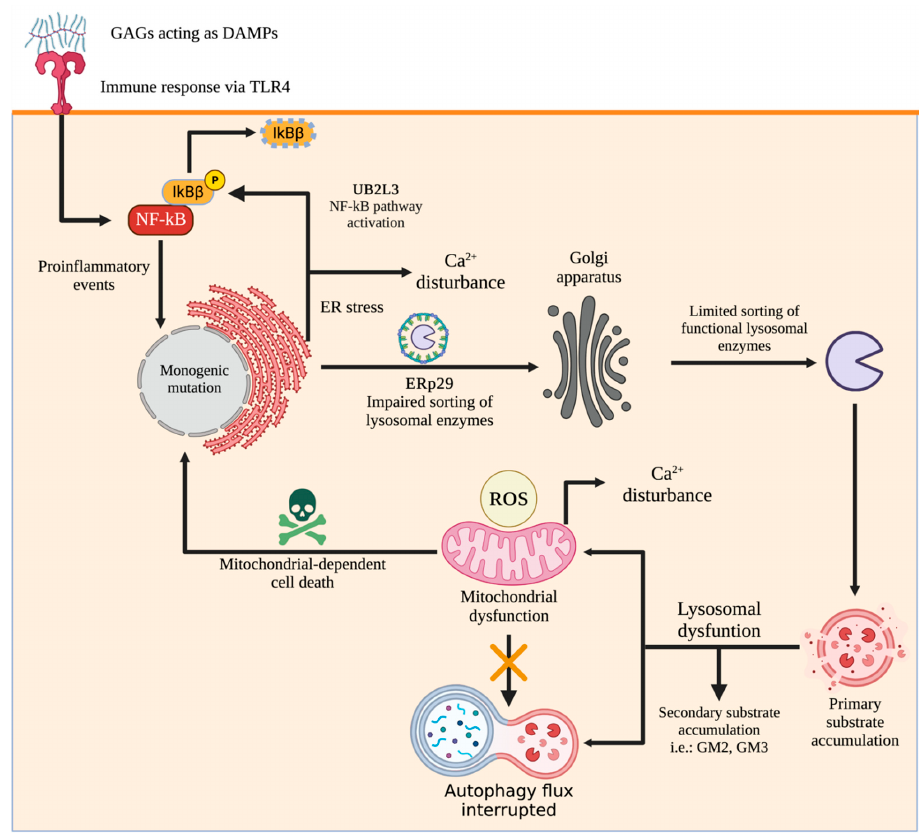
Figure 1. Global cellular changes occur during GAG accumulation. Note that primary GAG accu ‐ mulation affects not only lysosomal function but also any intracellular organelles contributing to altered cell homeostasis. Since GAGs act in cell–cell communication, their extracellular accumula ‐ tion, due to lack of plasma turnover [77], promotes inflammation ‐ related activation pathways since they are recognized as damage ‐ associated molecular patterns (DAMPs). For instance, soluble HS fragments can act as Toll ‐ like receptor 4 antagonists supporting the pro ‐ inflammatory events of MPS III [78,79]. This figure was created with